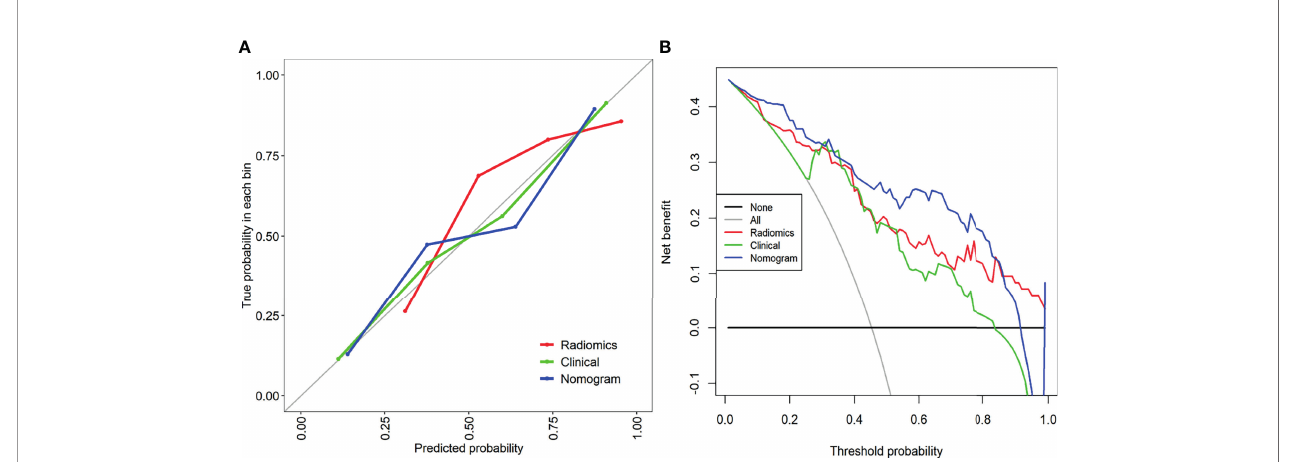
FIGURE 6 | (A) The calibration curve of the clinical model, combined radiology model, and nomogram. It is a curve with the model predicted PC probability as the X-axis and the actual PC probability as the Y-axis. The degree of coincidence between the calibration curve depicted and the 45-degree straight line re fl ects the predictive performance of each model. (B) Decision curve analysis of the clinical model, combined radiomics model, and mixed model. The Y-axis represents net income. The blue line represents the radiographic nomogram. Red lines represent radiomics models. The green line represents the model that contains only clinical features. The gray line represents the assumption that all patients have LN metastasis. The thin black line indicates the hypothesis that no patients have PC